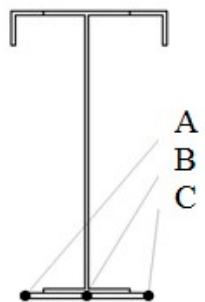
Figure 11. Arrangement of measuring points in the cross ‐ section halfway through the span length.